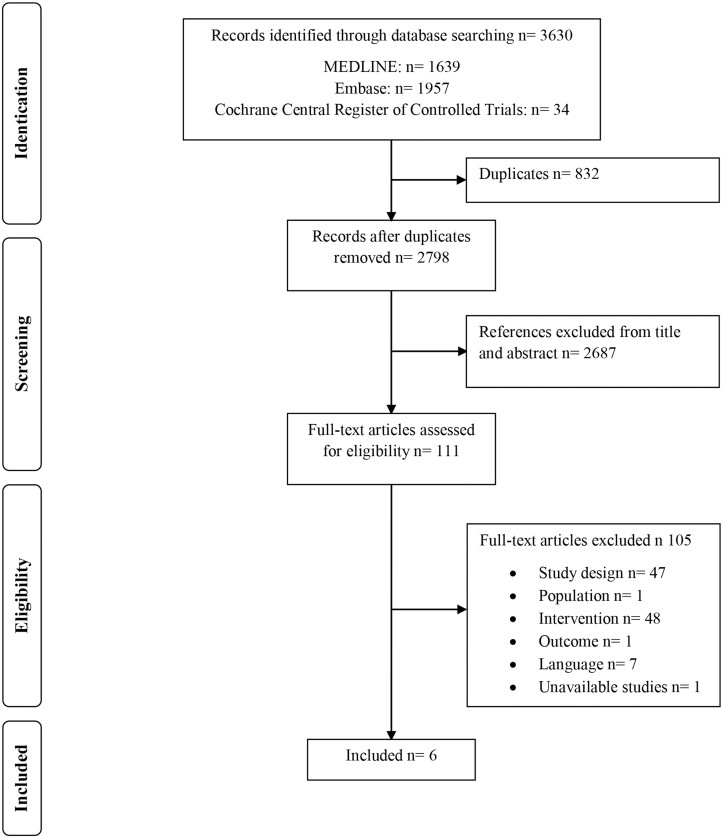
PRISMA flowchart of identification and selection of studies.